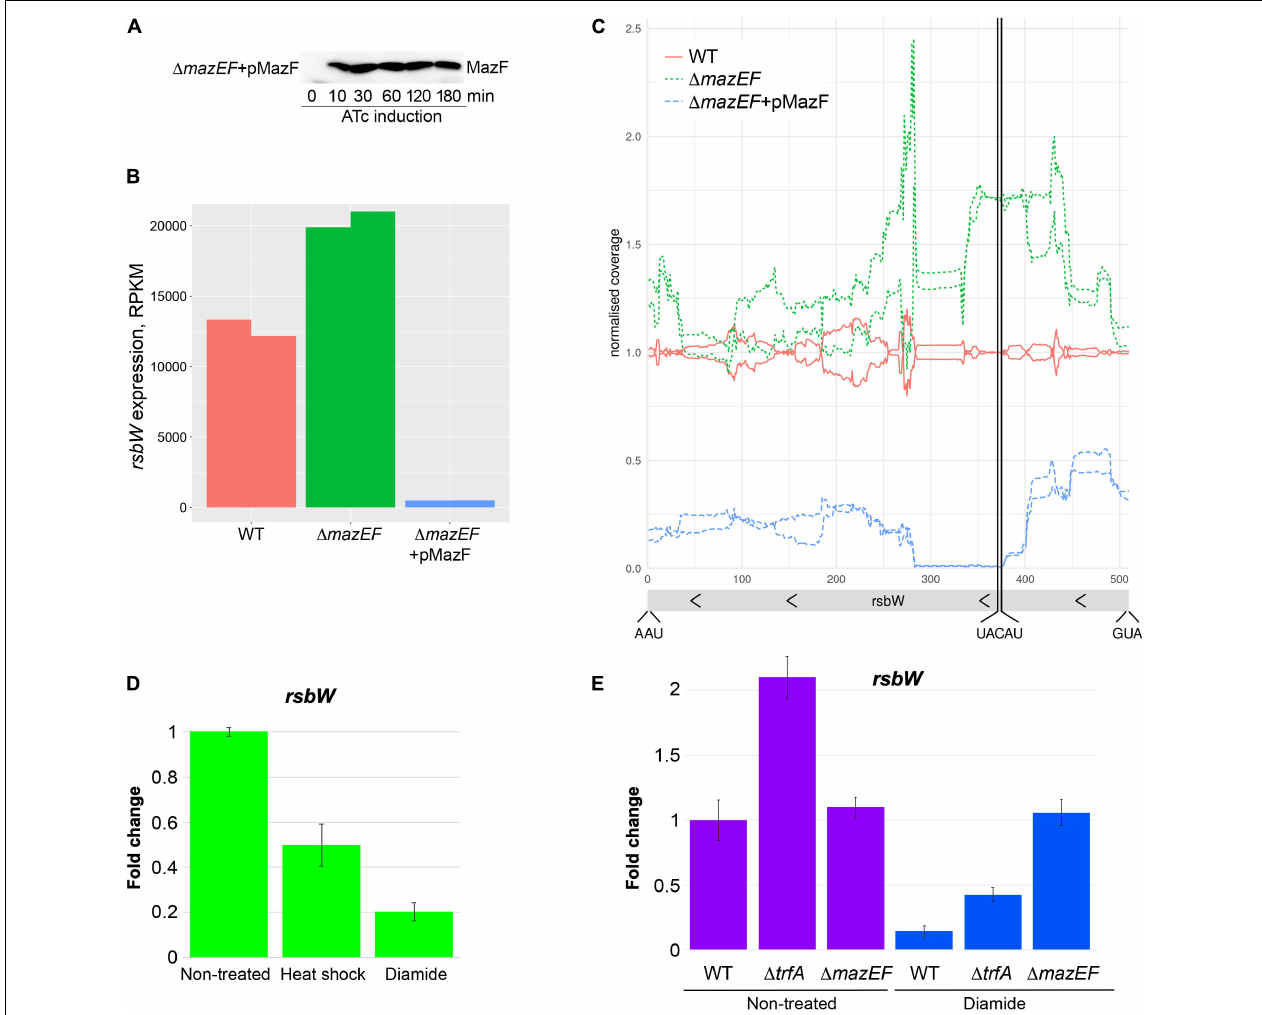
FIGURE 6 | MazF cleaves rsbW at UACAU cleavage site and MazF activity correlates with YjbH aggregation and Spx solubility. (A) Western blot analysis of MazF protein produced after anhydrotetracycline (ATc) induction. The mazEF deleted strain was transformed with the pRAB11-MazF plasmid (indicated as pMazF), expressing mazF gene under control of ATc inducible promoter. Cultures were collected before ATc induction (time 0). Then ATc was added and cultures were collected after 10, 30, 60, 120, and 180 min. Protein were extracted and analyzed by SDS-PAGE and western blot with anti-MazF antibody. (B) Effect of MazF on rsbW level. Wild-type or (cid:49) mazEF cells expressing either empty vector (WT and (cid:49) mazEF ) or mazF gene under control of ATc promoter ( (cid:49) mazEF + pMazF) were collected after 10 min of ATc induction. Total RNAs were purified and analyzed by RNA-seq. The RPKM values (Reads Per Kilobase Million) normalized by edgeR after excluding plasmid genes are show in duplicates. (C) In-depth analysis of rsbW gene expression by RNA-seq. Cells were treated as in panel (B) . RNA-seq coverage along the rsbW region relative to the average wild type is shown. The raw RNASeq coverage was normalized to the total number of reads over the chromosome region and then divided by the coverage of the wild-type samples. The start codon, stop codon and, MazF cleavage site are indicated. (D) RNAs were purified from cells described in Figure 5 . The level of rsbW RNA was measured by RTqPCR in non-treated cells and in cells treated for 30 min with either heat shock or oxidative stress induced by diamide. gyrB was used as a reference normalizing housekeeping gene. Fold change of rsbW gene expression in treated samples relative to non-treated samples was normalized to a reference gene ( gyrB ). The relative gene expression in non-treated cells was set to 1. (E) The level of rsbW RNA was measured by RTqPCR in wild-type, (cid:49) trfA or (cid:49) mazEF cells treated or not with diamide for 30 min, as described in panel (D) . The relative gene expression in non-treated wild-type cells was set to 1.